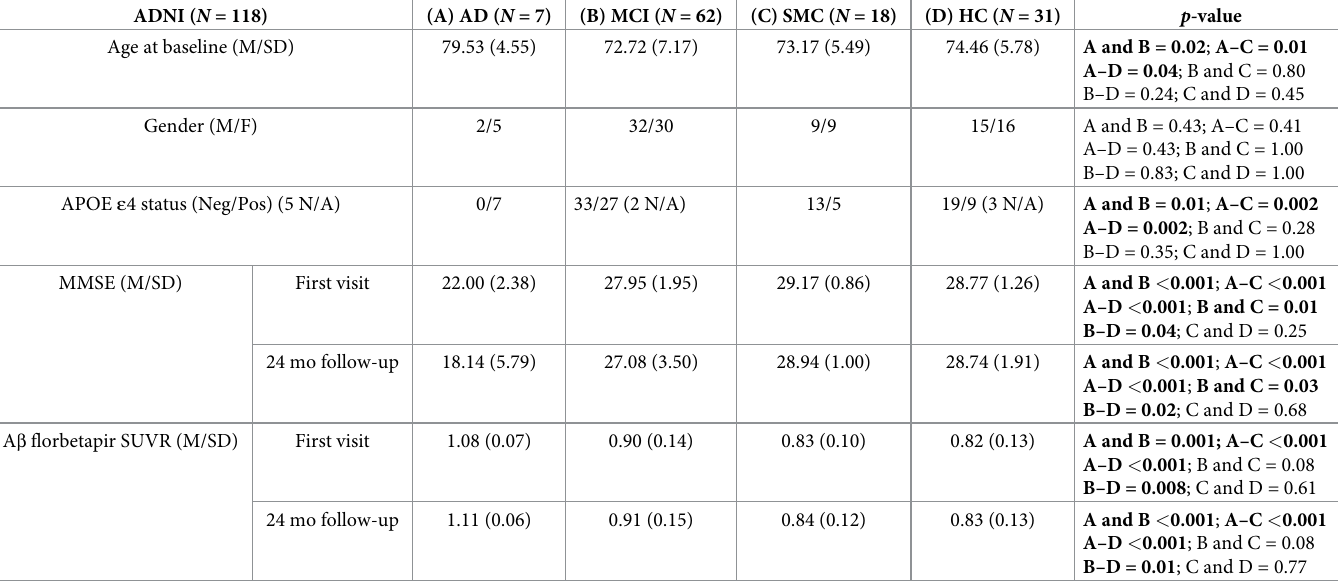
Table 1. Participant baseline